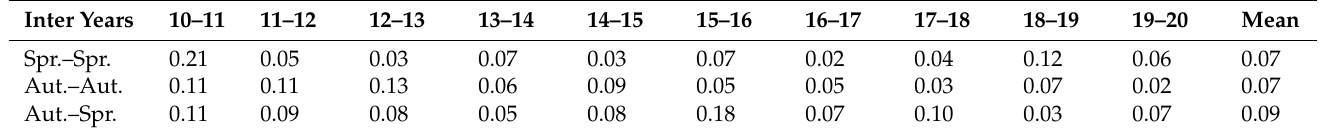
Table A3. Dissimilarity of spring and autumn in successive years.